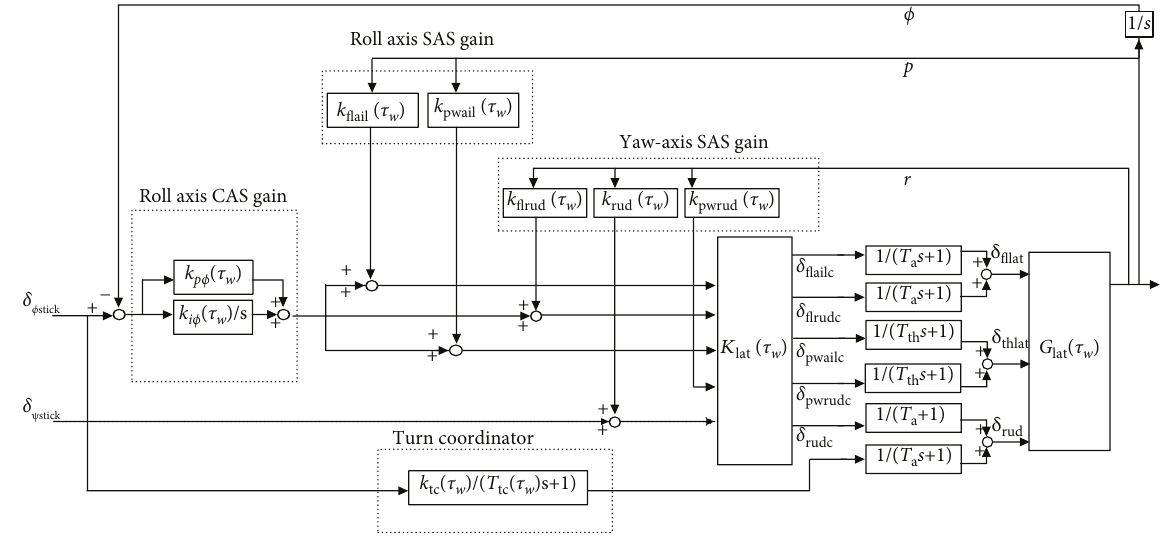
Figure 2: Conceptual fi gure of our method with a priori-given probabilistic density.